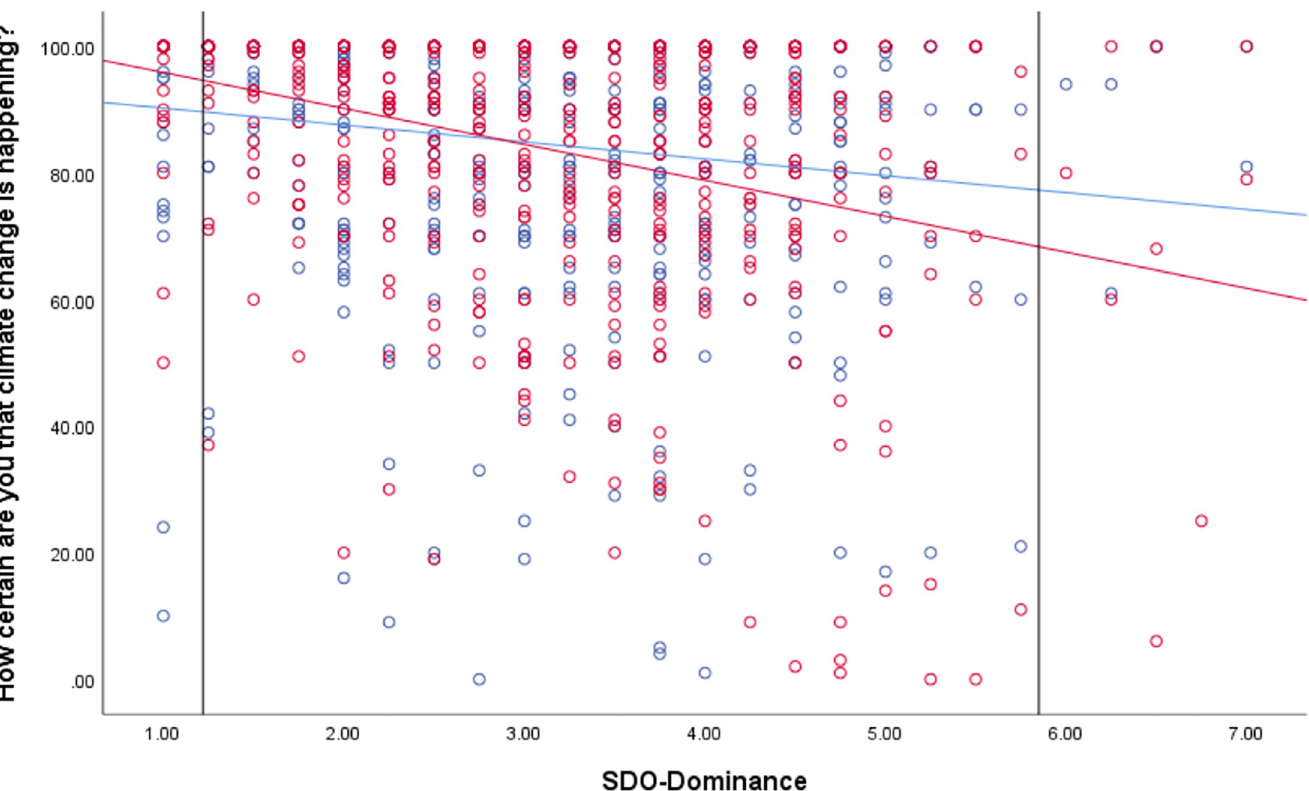
Fig 5. Association between SDO-D and certainty that climate change is happening by temporal framing condition (past = blue, future = red). Solid vertical lines represents the Johnson-Neyman value. Outside of these bounds, the differences in certainty ratings by condition are significant.